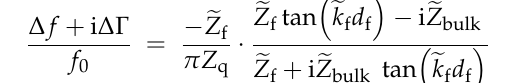
Figure 20: An example of a film resonance. At some point, the frequency jumped as discussed